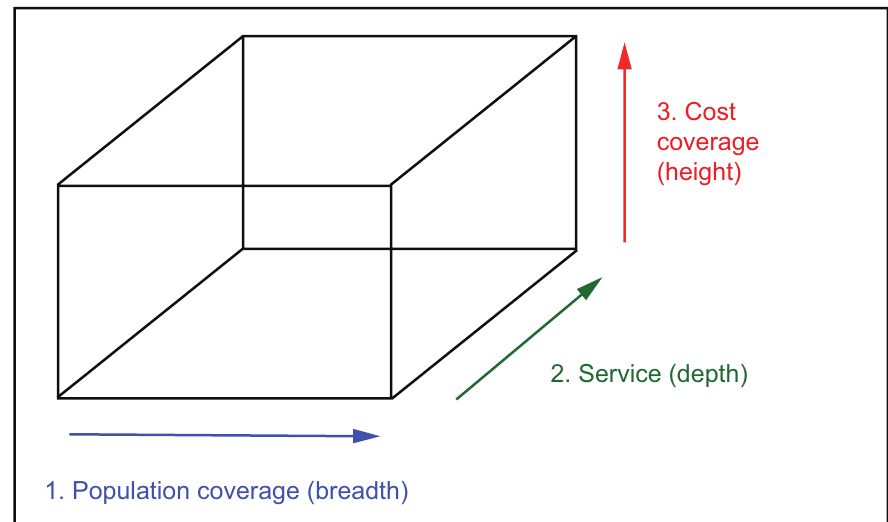
1. Population coverage